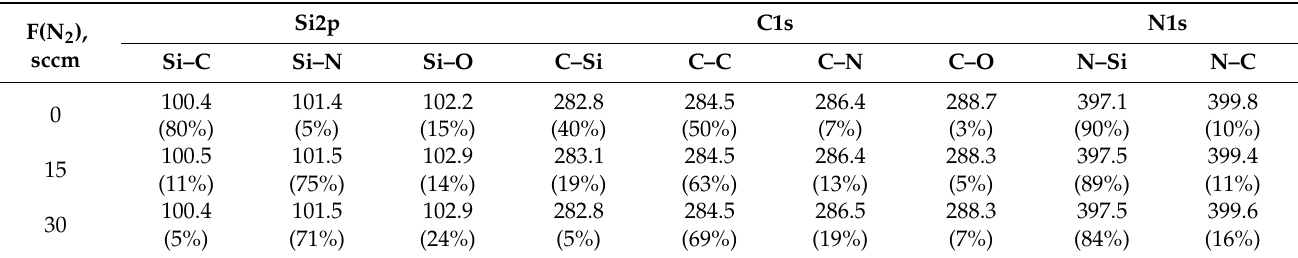
Table 7. XPS analyzed binding energy for Si2p, C1s, and N1s core